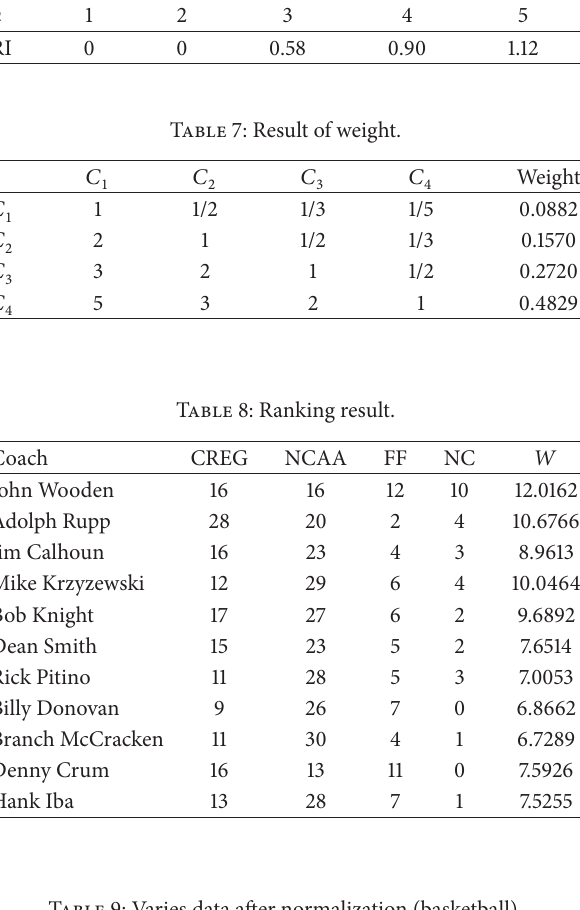
Table 9: Varies data after normalization (basketball).